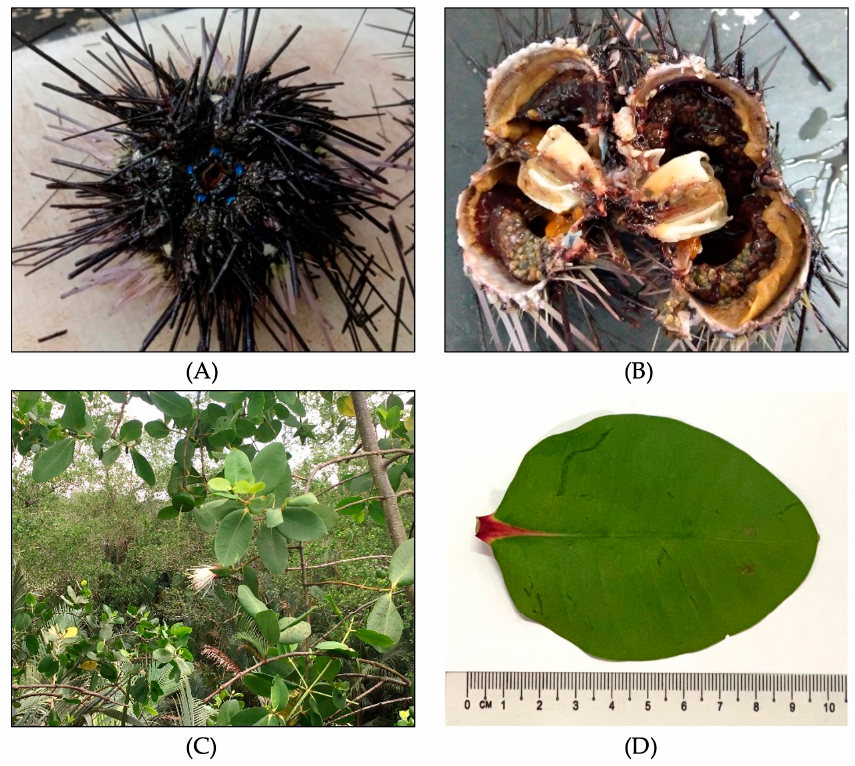
Figure 1. Morphology of the marine resources. ( A ) External structure of D. setosum , ( B ) Internal structure of D. setosum , ( C ) Leaves branches to end with flowers of S. lanceolata , ( D ) S. lanceolata leaves.